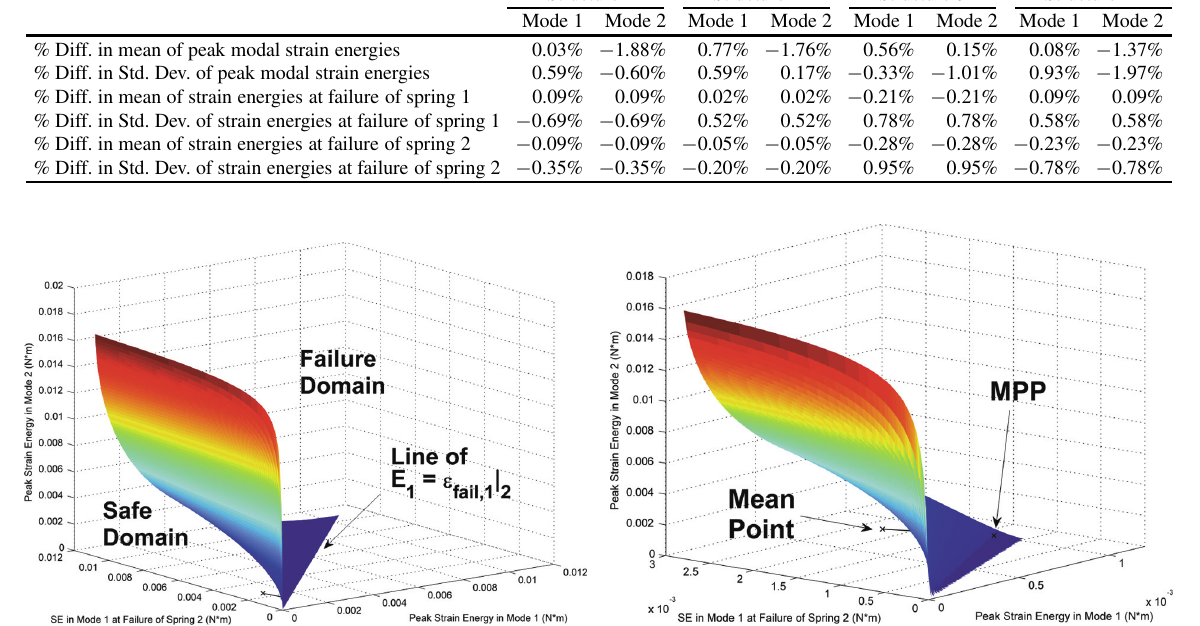
Fig. 4. Zoom-in on Fig. 3 showing